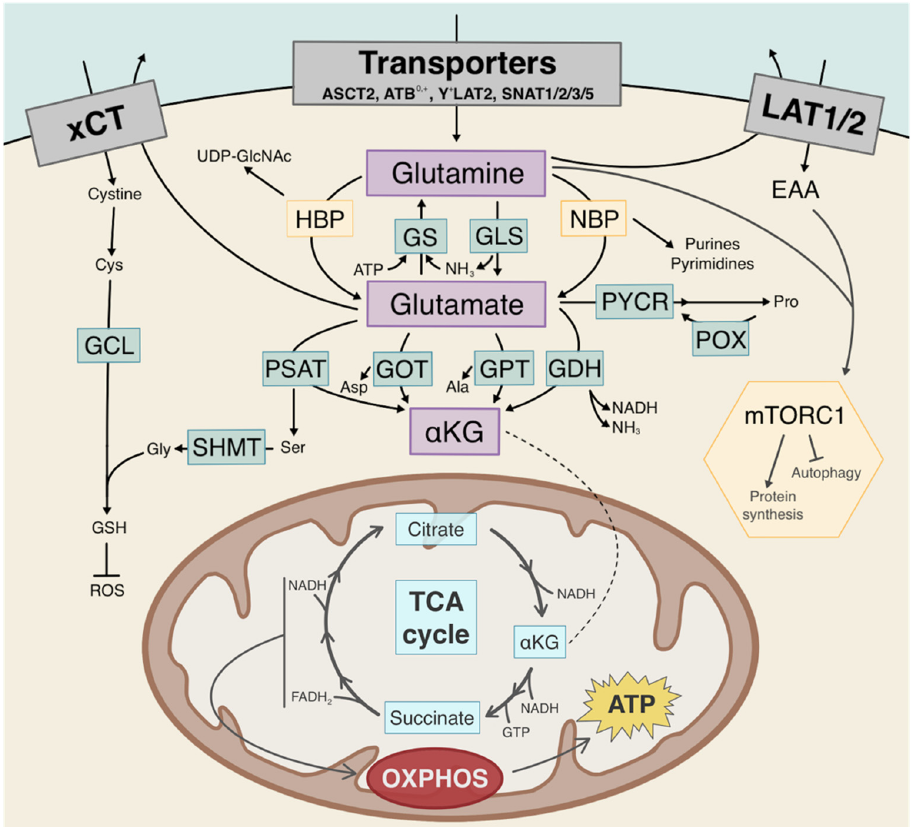
Figure 2. Intracellular and metabolic pathways of glutamine. Glutamine can integrate into a wide variety of metabolic and intracellular pathways, such as hexosamine biosynthesis (HBP), nucleotide synthesis (NBP), and mitochondrial metabolism through conversion to glutamate by glutaminase (GLS), and further to α -ketoglutarate ( α KG) by glutamate dehydrogenase (GDH) or transamination (PSAT/GOT/GPT). Glutamine can be synthetized endogenously by glutamine synthetase (GS). Through glutamate, glutamine integrates the synthesis of many amino acids such as alanine, aspartate, serine, glycine (SHMT), and proline (P5CS). Glutamine can be exchanged for essential amino acids (EAA) through the LAT transporters, which, in turn, stimulate the mechanistic Target of Rapamycin Complex 1 (mTORC1) signaling pathway. Additionally, glutamate can be exchanged for cystine by xCT, upstream of glutathione (GSH) synthesis through glutamate-cysteine ligase (GCL). Interestingly, recent studies have found that glutamine itself acts as a relevant regulator of c-Myc protein expression. In HCT116 cells, a concomitant decrease in c-Myc expression was observed when the cells were deprived of glutamine, which was restored by replenishing the cellular medium with glutamine [23]. This was similarly observed in various cell lines such as U266 and INA-6 multiple myeloma cell lines [31] as well as neuroblastoma SK-N-AS and SH-SY5Y cells [32]. Dejure et al. sought to further under- stand the mechanism through which glutamine regulated c-Myc expression. Pulse-labeling cells with 35 S-Methionine showed that glutamine restriction shut down the translation of MYC transcripts in a mTORC1-independent manner [23]. Furthermore,